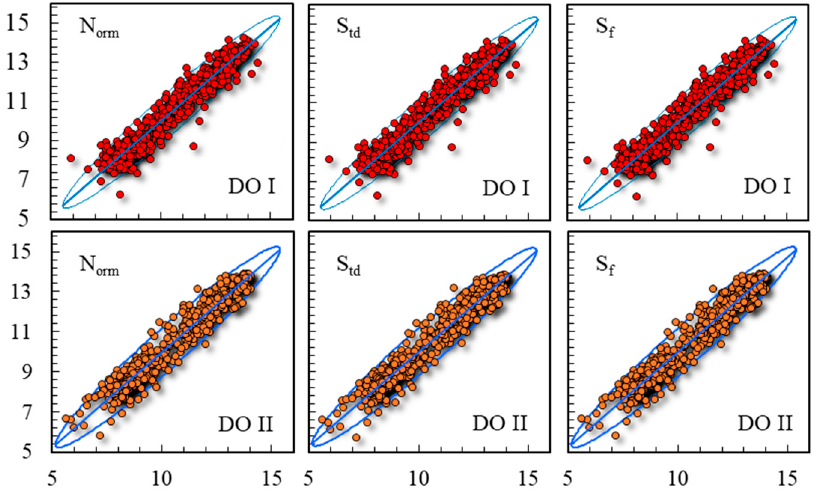
Figure 8. Scatter plot of modeled vs. observed data, with 95% confidence ellipses, at both DO stations I and II.